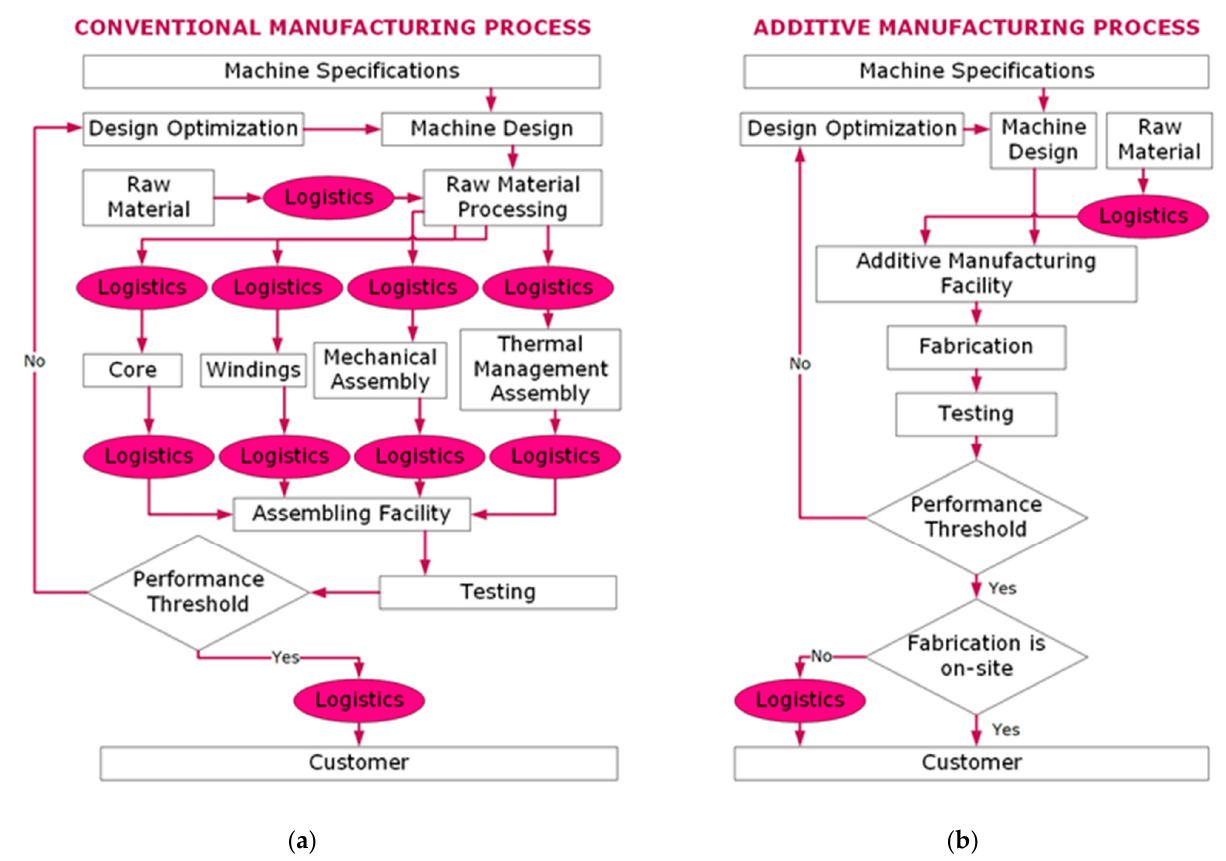
Figure 1. Flowchart comparing ( a ) conventional manufacturing methods and ( b ) additive manufac- turing with advantages and solutions still in need of further in-depth research.